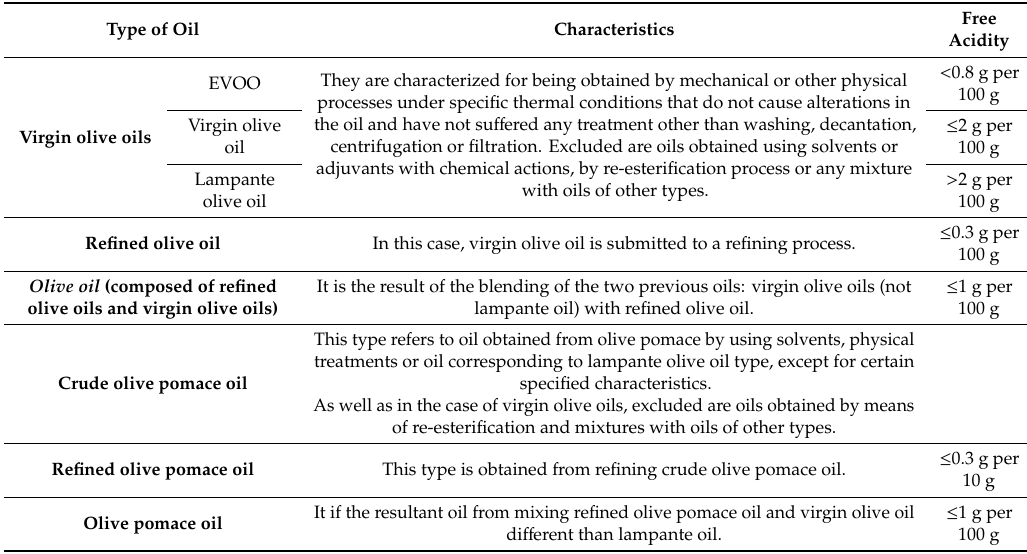
Figure 2. Summary of the oil extraction process focused on extra virgin olive oil (EVOO) production. The boxes with discontinuous outline refer to the obtainment of other type of oils. Modified from different schemes of [10,17]. Table 1. Types of olive oils. Modified from EU Council Regulation (EC) No 1234 / 2007